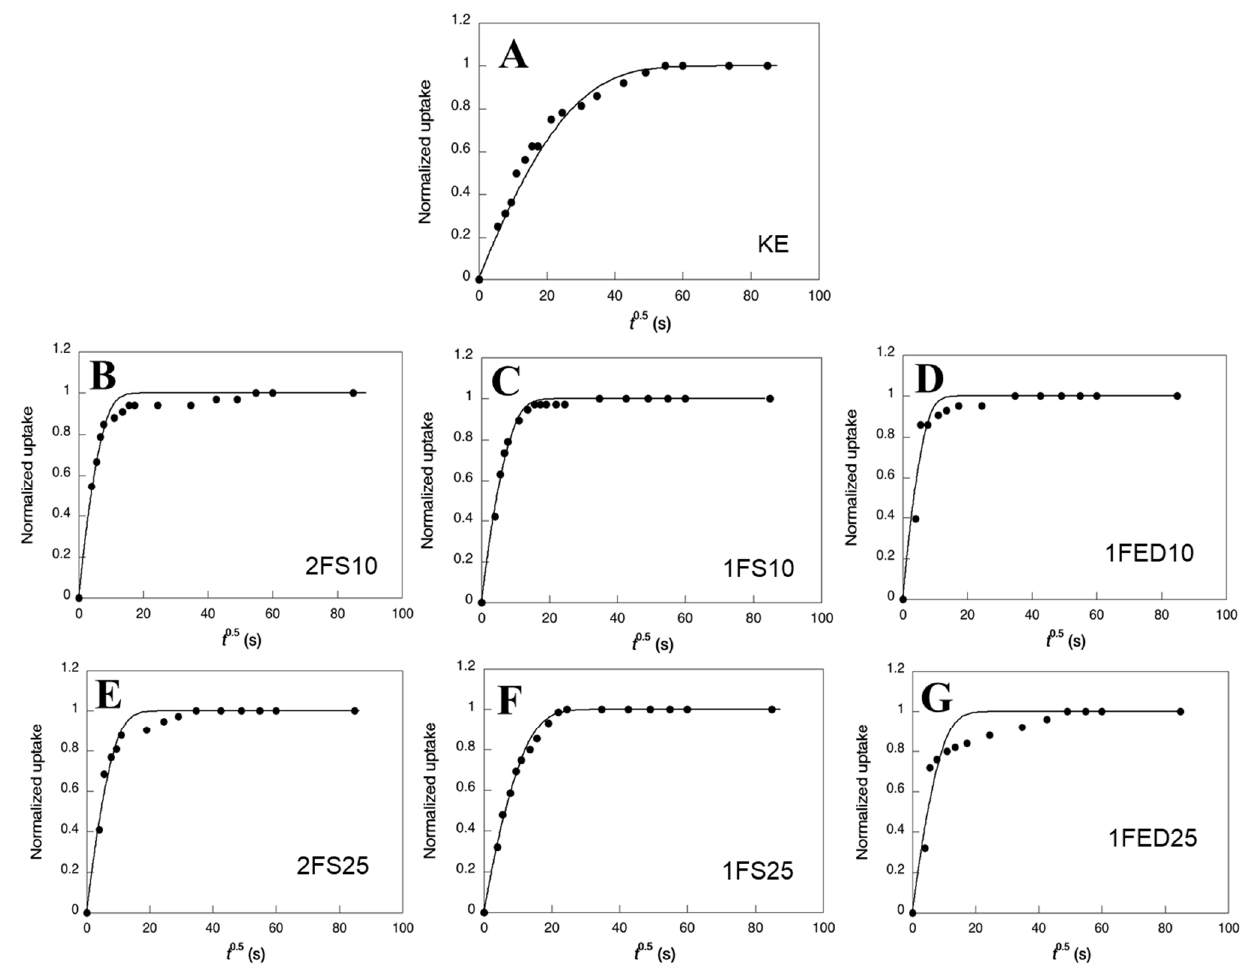
Figure 5. Normalized water uptake as a function of the square root of time (t 0.5 ) for the different systems obtained: ( A ) KE, ( B ) 2FS10, ( C ) 1FS10, ( D ) 1FED10, ( E ) 2FS25, ( F ) 1FS25, and ( G ) 1FED25. Data points refer to experimental values and the curves refer to the modeling.